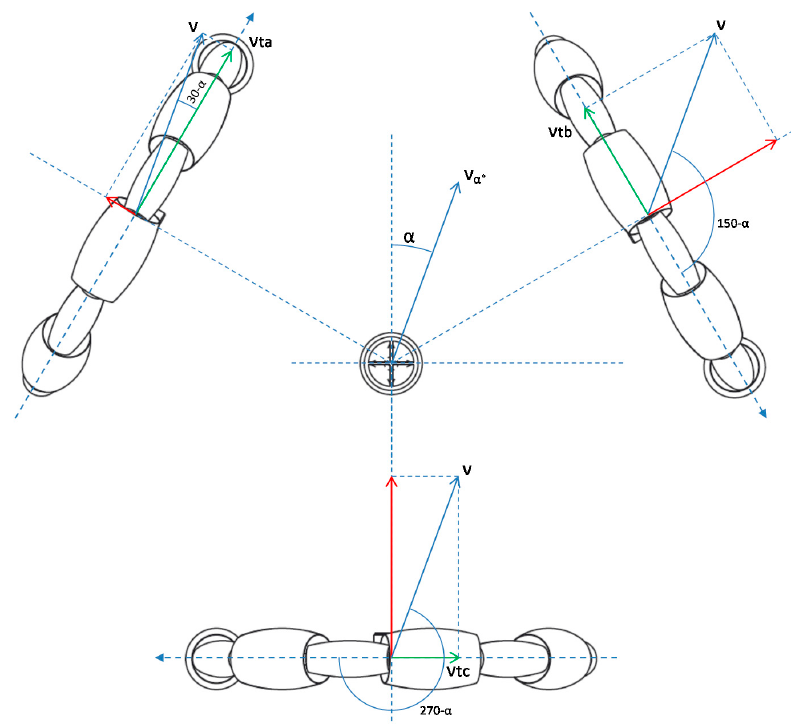
Figure 14. Kinematic diagram of the translation of the mobile robot: v and α define the velocity vector of the mobile robot in polar form and v ta , v tb , and v tc are the velocity in each of the wheels caused by translation.